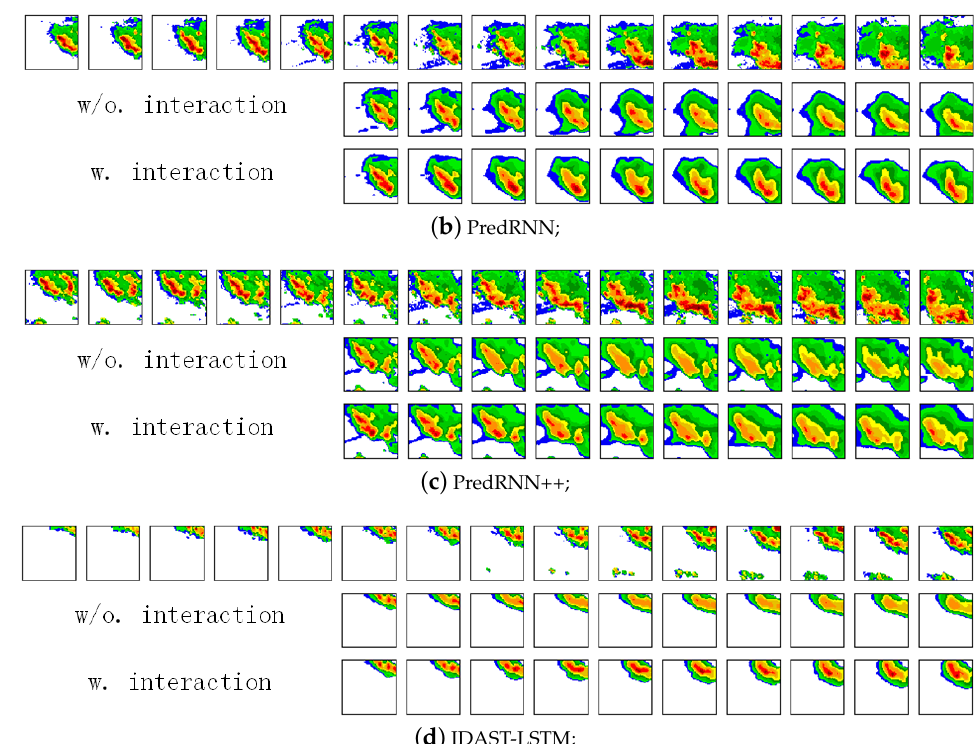
Figure 14. The four group interaction ablation examples from the CIKM AnalytiCup 2017 competition. These groups are ConvLSTM, PredRNN, PredRNN++, and DAST-LSTM respectively from top to bottom. The first five images in the first row are the input, and the remainders denote the ground- truth output. Other rows are the prediction of various models. (Best view in color).